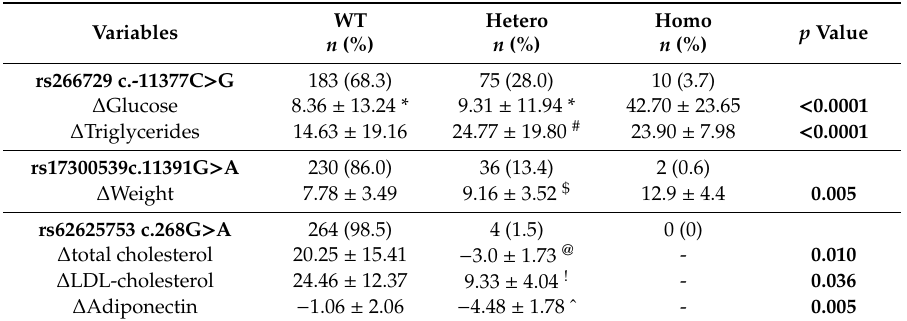
Table 4. Di ff erences in ∆ values for the significant biochemical parameters on the basis of the main genotypes in people with severe